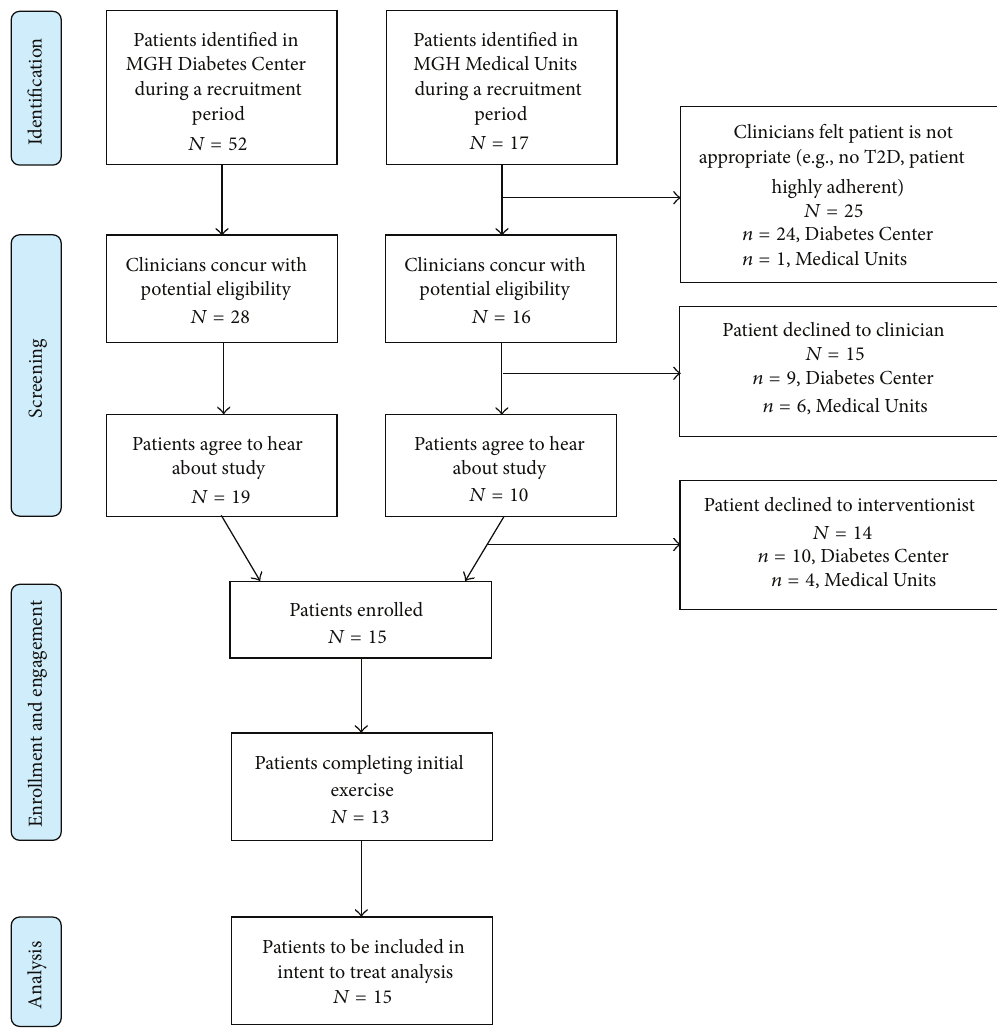
Figure 2: Flow diagram of